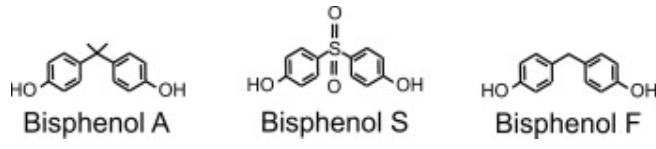
Figure 13. Chemical structure of bisphenols A, S and F.